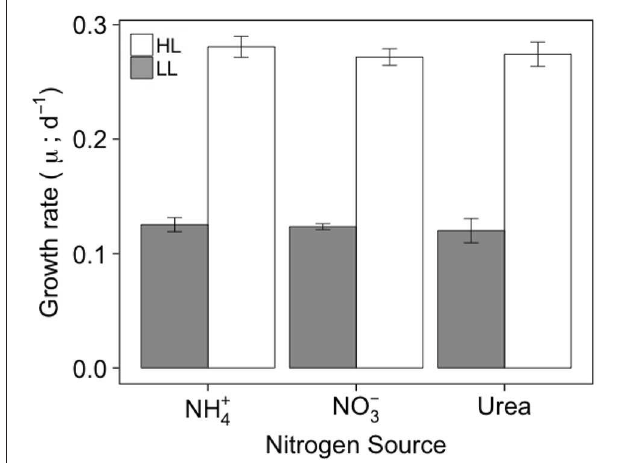
TABLE 2 | Summary of statistical analyses relating N form, irradiance or their interaction to the growth rate (d − 1 ), cell diameter ( µ m), volume ( µ m 3 ),